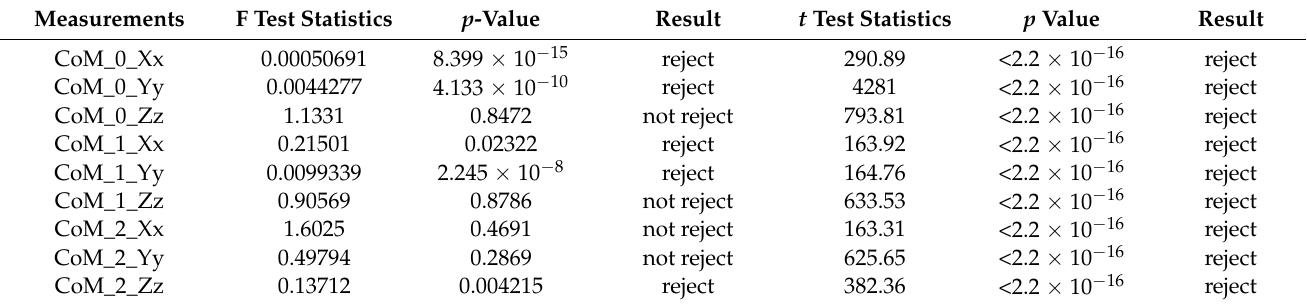
Table 9. CoM F test and t